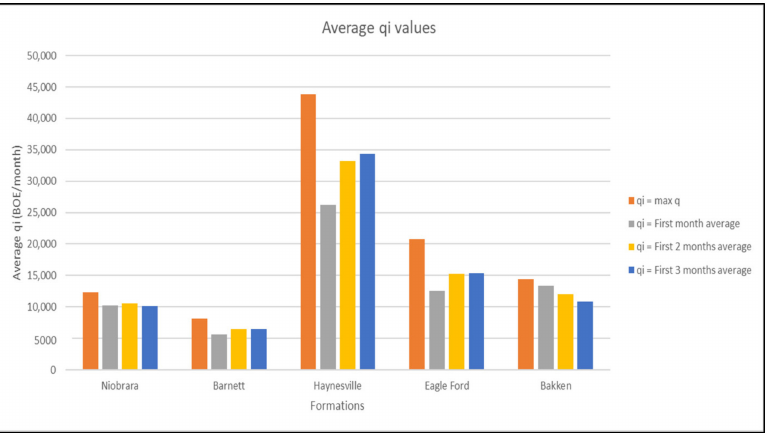
Figure 9. Average of the four different values of initial flow rate definitions (q i ) in BOE per month for all wells in each formation.